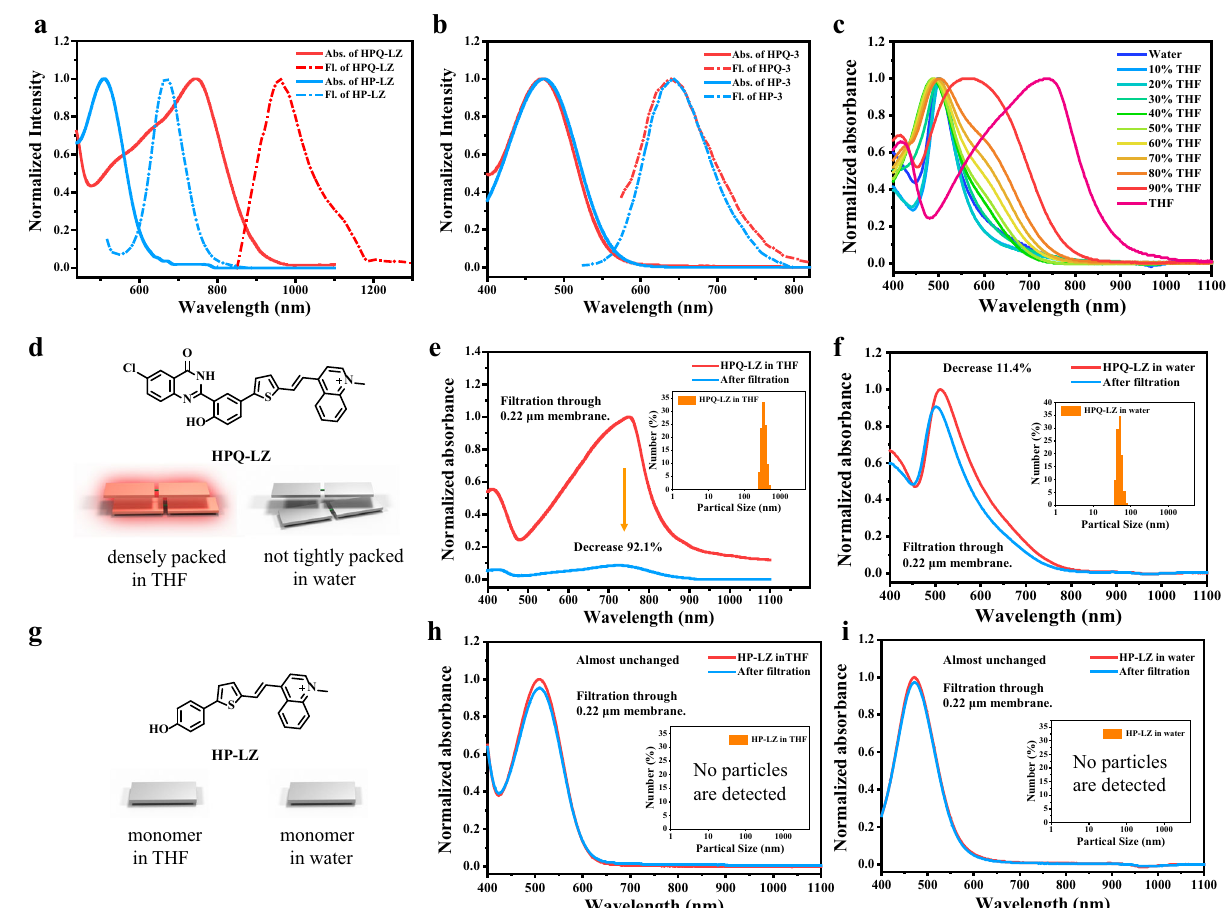
Fig. 3 | In vitro study of spectral and particle properties. a Normalized absor- bance and fl uorescence spectrum of HPQ-LZ and HP-LZ in the THF. b Normalized absorbance and fl uorescence spectrum of HPQ-3 and HP-3 in the THF. c Normalized absorbance of HPQ-LZ in different ratios of THF in water. d The chemical structure of HPQ-LZ . e Normalized absorbance of HPQ-LZ in THF and absorbance after fi ltration through 0.22 μ m membrane, the illustration showed